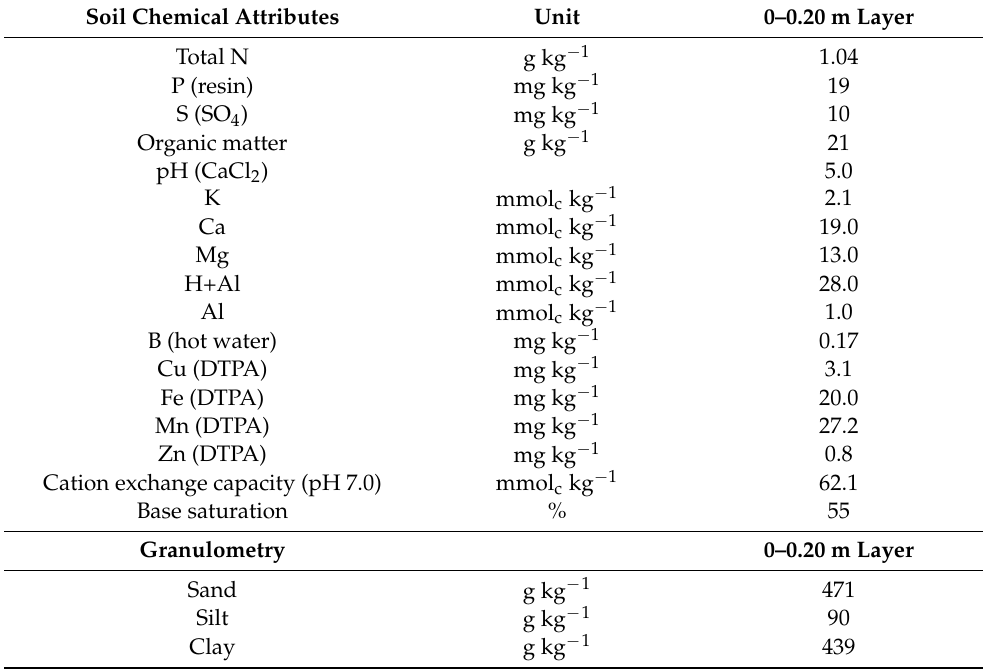
Table 7. Soil chemical attributes and granulometry in 0–0.20 m depth before Si amendment source application in